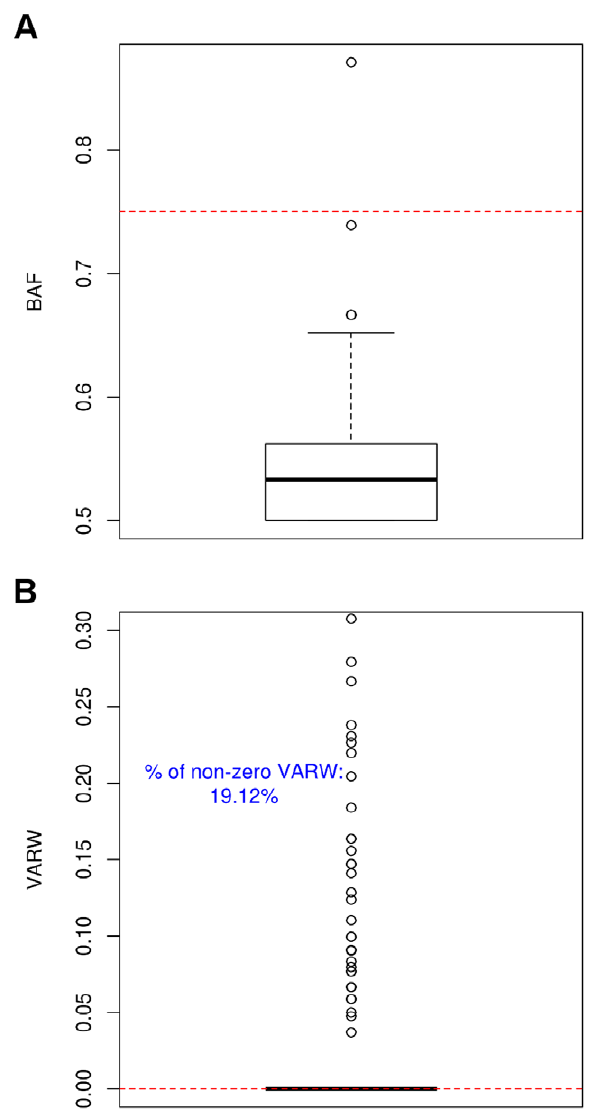
Figure 2. Distribution of BAFs and VARWs for indels derived from DH10B. Boxplots for BAFs and VARWs of indels detected from PGM TM data were plotted. (A) The majority of BAFs were skewed towards the minimum. The dotted red line indicates the selected BAF th of 0.75. Only one indel exceeded this BAF th . (B) The majority of the VARWs were equal to zero, indicated by a dotted red line. The percentage represents the proportion of non-zero VARW.